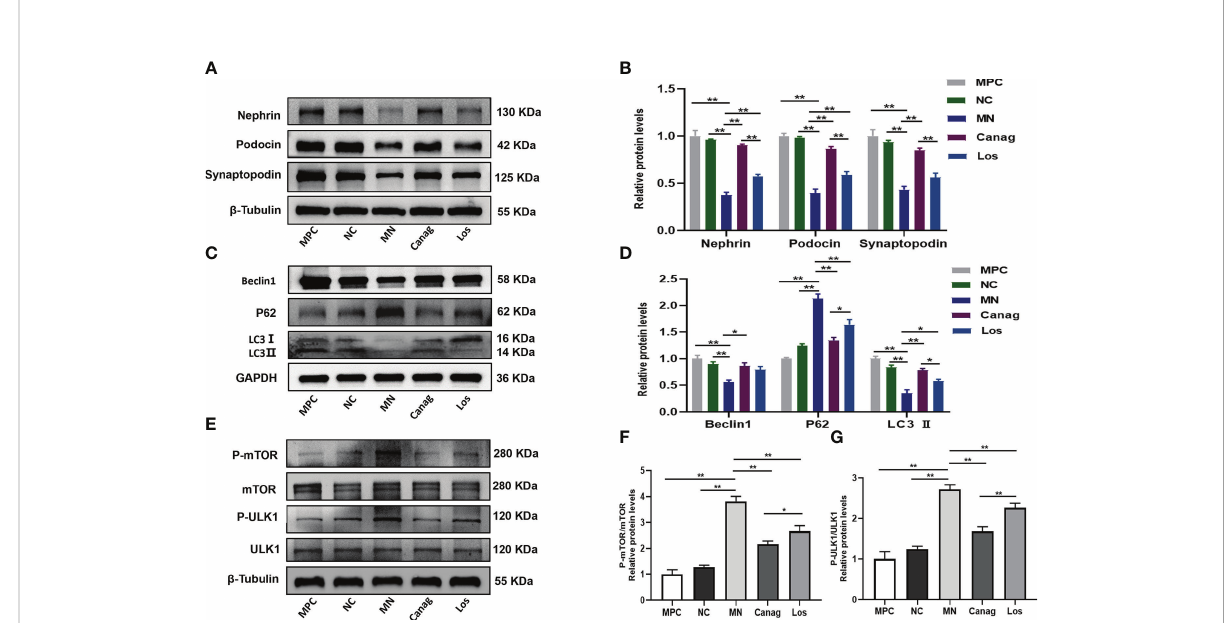
FIGURE 5 Canagli fl ozin ameliorates podocyte autophagy inhibiteded by B lymphocytes of MN rats. MPC group: control of normal podocytes not co- cultured with B-cells; NC group: podocytes were co-cultured with B-cells of normal control rats; MN group: podocytes were co-cultured with B-cells of MN rats; Canag group: podocytes were co-cultured with B-cells of rats treated with canagli fl ozin; Los group: podocytes were co- cultured with B-cells of rats treated with losartan. (A, B) Western blots and quanti fi cation analyses of nephrin, podocin, and synaptopodin in podocytes. (C, D) Western blots and quanti fi cation analyses of beclin1, p62, and LC3 II in podocytes. (E – G) Western blots and quanti fi cation analyses of the expression of mTOR/ULK1 in podocytes. Data are shown as mean ± SEM values. One-way ANOVA followed by Tukey ’ s test for multiple comparisons was used. *P < 0.05, **P <